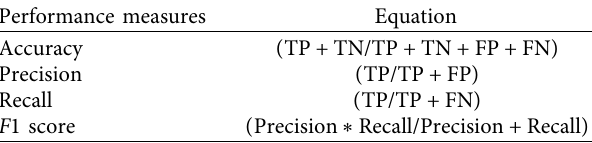
Table 10: Performance